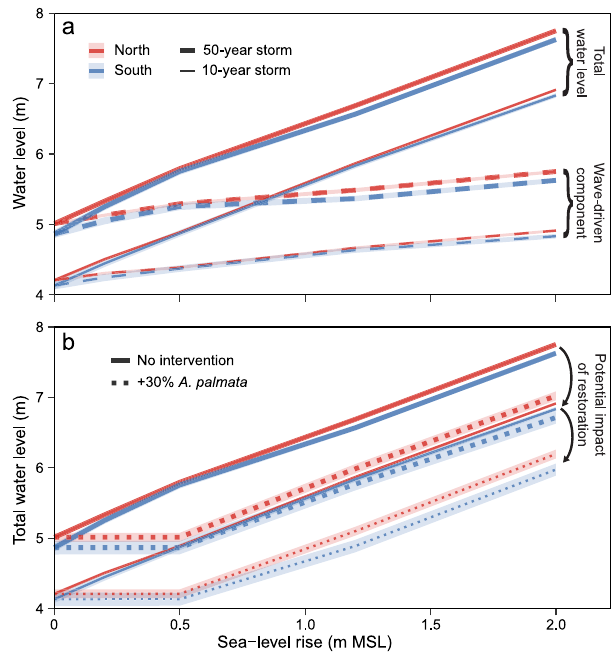
Fig. 5 | Summary of the alongshore mean (± standard error [SE]) of maximum total water levels predicted to reach modeled sites (shown in Fig. 4) along the northern ( n =145) and southern ( n =71) shorelines of Buck Island by 2100 under sea-level rise (+0 to +2.0 m), storms (10- and 50-year storms), and coral restorationscenarios.a Mean(±SE)maximumtotalwaterlevelsforeachsea-level rise and storm scenario with reef degradation (solid lines) and the wave-driven component of total water levels (dashed lines). b Comparison of the total water levels with reef degradation in a to mean (± SE) total water levels estimated with reef elevation changes (Fig. 3) projected under a 30% increase in A. palmata cover through restoration (dotted lines), demonstrating how successful restoration couldhelp mitigate some of the impacts offuture sea-level rise atBuck Island (i.e., by reducing total water levels by up to 0.81m). Note that because this fi gure pre- sents spatially averaged trends, the alongshore variability apparent in Fig. 4, including areas of non-linear total-water-level changes, is less clear. Uncertainties (SEs) for the restoration scenario are the root-sum-squares of the uncertainties in total water levels and of projected reef-elevation change with